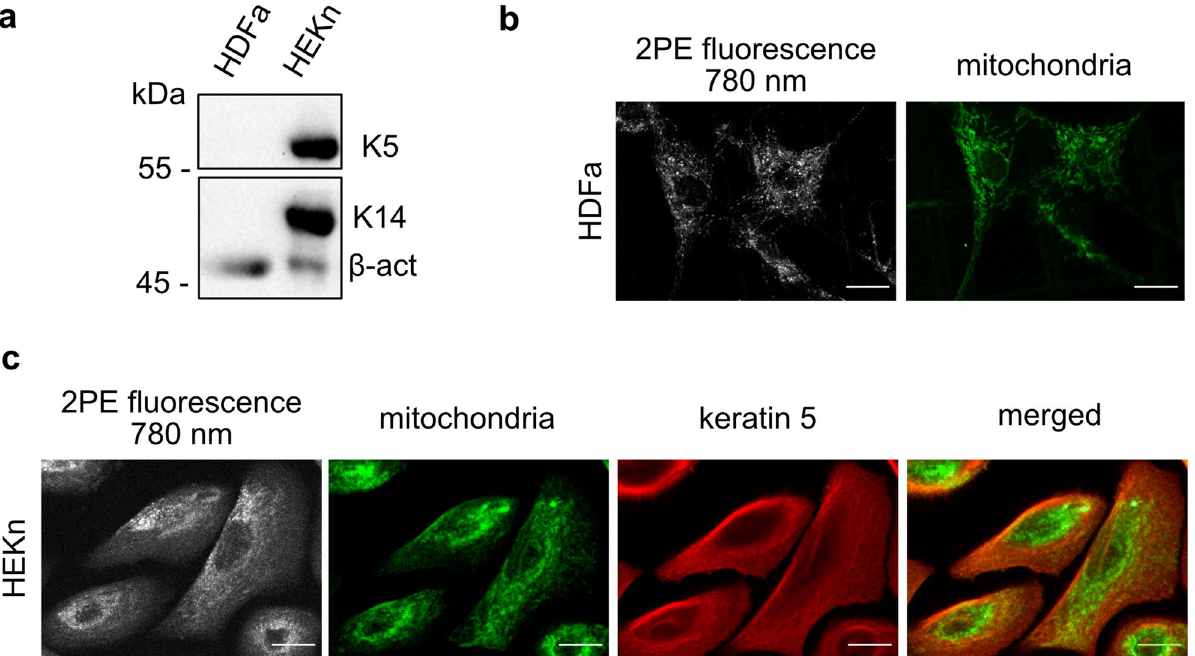
Figure 5. The overlap of keratin intermediate filaments with the mitochondria in keratinocytes makes it challenging to separate the 2PE mitochondrial and keratin signal. Intrinsic cellular fluorescence of keratinocytes and fibroblasts investigated with respect to keratin levels, and immunostaining. ( a ) Levels of keratin 5 and keratin 14 in keratinocytes and fibroblasts analyzed by Western blotting. The membrane was cut in half prior to the antibody probing. The membrane containing proteins larger in size than 55 kDa was probed with an anti-cytokeratin 5 antibody, followed by an incubation with a secondary antibody. The membrane containing proteins smaller in size than 55 kDa was probed simultaneously with anti-cytokeratin 14 and anti-β-actin antibody, followed by simultaneous incubation with the secondary antibodies. The membranes were imaged with the same exposure time (2 min). Protein loadings were standardized for total protein content based on Coomassie blue stained gels and densitometric analysis. An antibody to β actin was used on the same membrane to demonstrate even loading. ( b ) Intensity MPM image of fibroblasts excited at 780 nm collected with GaAsP detector on an LSM 710 NLO microscope. Cells were fixed and stained for mitochondria with an antibody to ATP5A after the label-free MPM imaging. Stained fibroblasts were then imaged on the same system using a confocal module and an Ar-laser at 488 nm. ( c ) Intensity MPM image of keratinocytes excited at 780 nm collected with GaAsP detector on an LSM 710 NLO microscope, which were fixed and stained for keratin 5 with an antibody, and mitochondria with an ATP5A antibody, after the label-free MPM imaging. Stained keratinocytes were then imaged on the same system using a confocal module and an Ar-laser 488 nm (mitochondria) and Laser diode 561 nm (keratin 5). Images were merged to visualize mitochondrial and